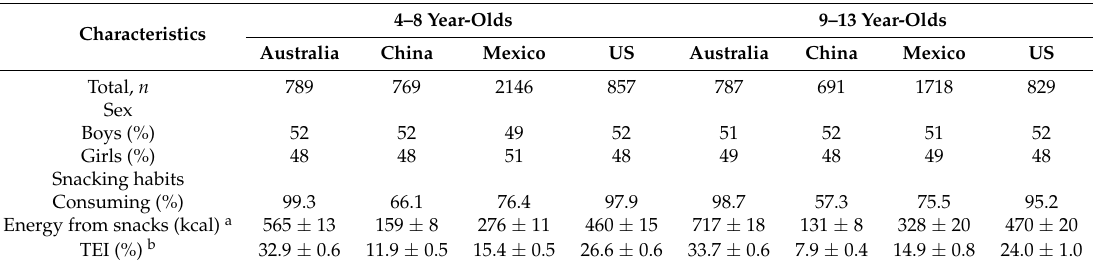
Table 1. Characteristics of the study populations and their snacking habits.